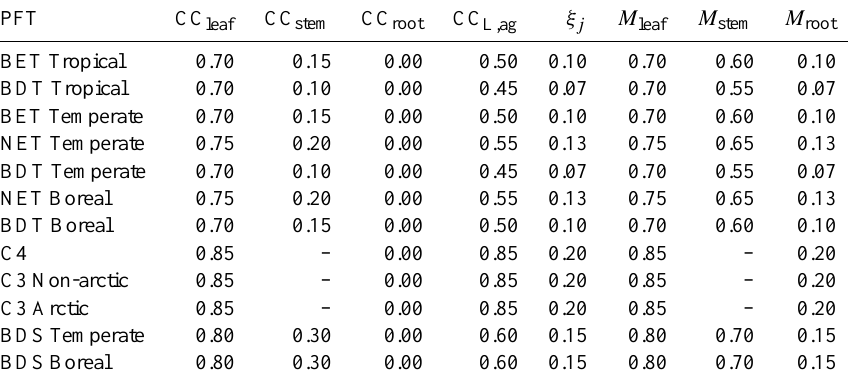
Table 2. PFT-specific parameter values for combustion completeness factors for leaves (CC leaf ), stems (CC stem ), roots (CC root ) and above- ground litter (CC L,ag ); whole-plant mortality factor ( ξ j ); tissue-mortality factors for leaves ( M leaf ), stems ( M stem ) and roots ( M root